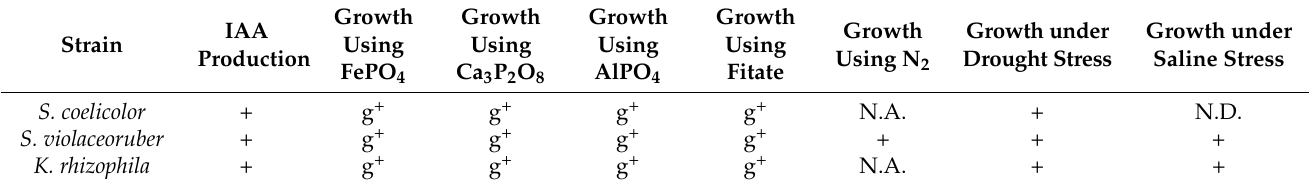
Table 1. Characterization of multiple PGP traits of actinobacteria strains